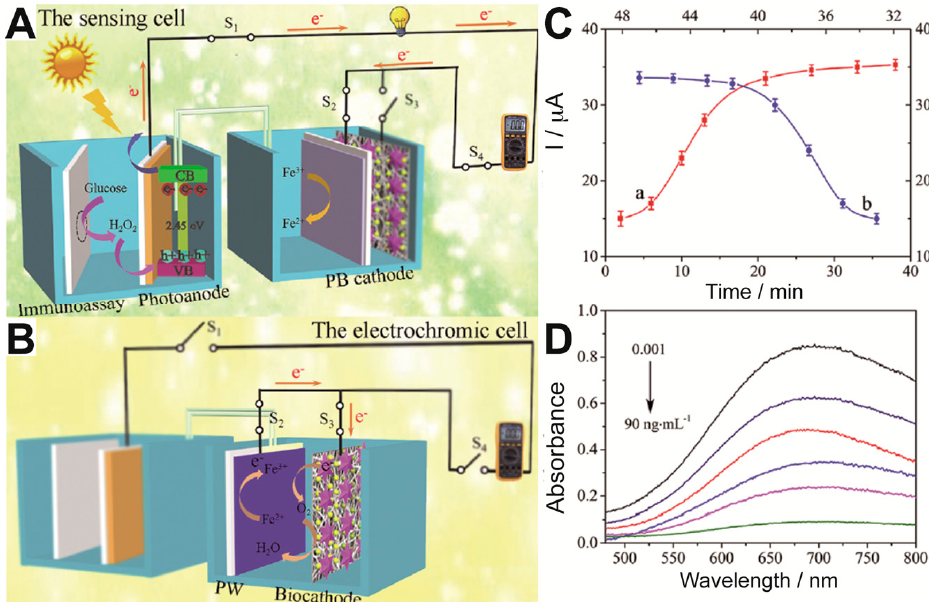
Figure 7. ( A ) Analytical principle of the photoelectrochemical sensing cell triggered by an immunoreaction and connected to a digital multimeter readout. ( B ) Analytical principle of the readout electrochromic cell. ( C ) Time optimization of (a) glucose oxidation and (b) immunosensing processes. ( D ) Electrochromic sensor decreasing absorbance of Prussian Blue, reduced to Prussian White. Adapted from ref. [36].